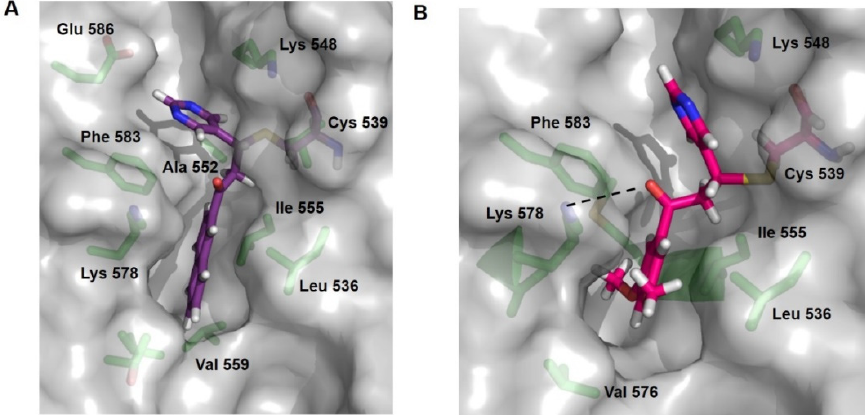
Figure 5. ( A ) Best CovDock solution of compound 9 (shown as purple sticks) at the NES-binding cleft of XPO1 (shown as light grey surface). ( B ) Best CovDock solution of compound 10 (shown as magenta sticks) at the NES-binding cleft of XPO1 (shown as light grey surface). Selected interacting residues from the NES-binding cleft are shown in green sticks and labeled, and hydrogen bond is shown as dashed